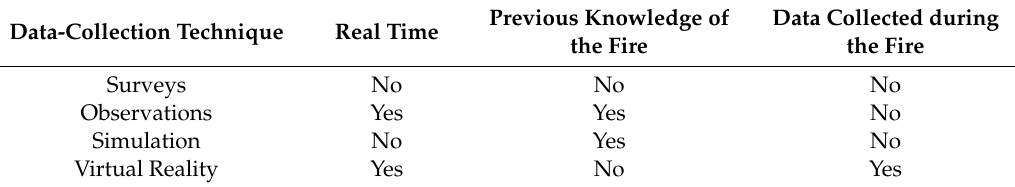
Table 1. Data-collection techniques.